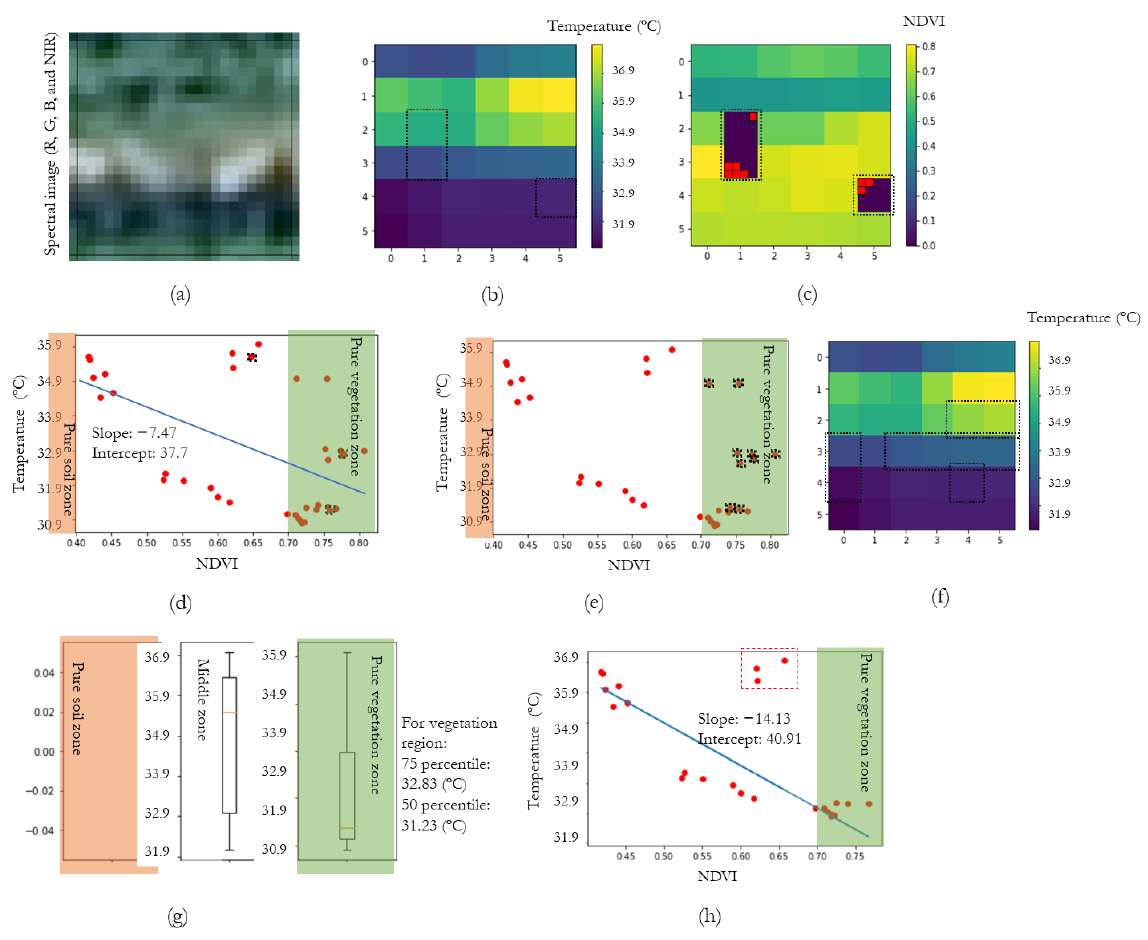
Figure 4. One example showing the performance of the method in one TSEB modeling pixel (3.6 m resolution grid) to separate the temperature as canopy and soil temperature. ( a ) Spectral image at 0.15 m resolution, along with ( b ) co-collected temperature image and ( c ) generated NDVI image at 0.6 m resolution. Pixels highlighted with the dashed line in ( b ) and ( c ) represent the locations of shadow at 0.6 m pixel scale, and the 0.15 m red pixels in ( b ) represent shadow locations at 0.15 m pixel scale; ( d ) linear relationship between temperature and NDVI considering 36 pairs of pixels within the 3.6 m grid. The red points highlighted by dashed lines represent the temperatures from the shadow pixels. The pure vegetation zone whose x-axis value is higher than 0.70 and the pure soil zone whose x-axis value is lower than 0.40 are displayed at each side of the x-axis; ( e ) Within the pure vegetation zone, pixels with temperatures higher than its 75th percentile temperature are highlighted by dash-lined boxes; ( f ) pixel locations where the temperature is higher than its 75th percentile temperature are highlighted on the temperature image; ( g ) box plots for soil region, NDVI ∈ [0, 0.40], vegetation region, NDVI ∈ [0.70, 1], and the middle part region, NDVI ∈ (0.4, 0.7). The 50th and 75th percentile temperatures within the pure vegetation zone are shown on the right side; ( h ) linear relationship between temperature and NDVI obtained by eliminating vegetation-temperature pixels above the 75th percentile temperature, highlighted by the red dashed-line